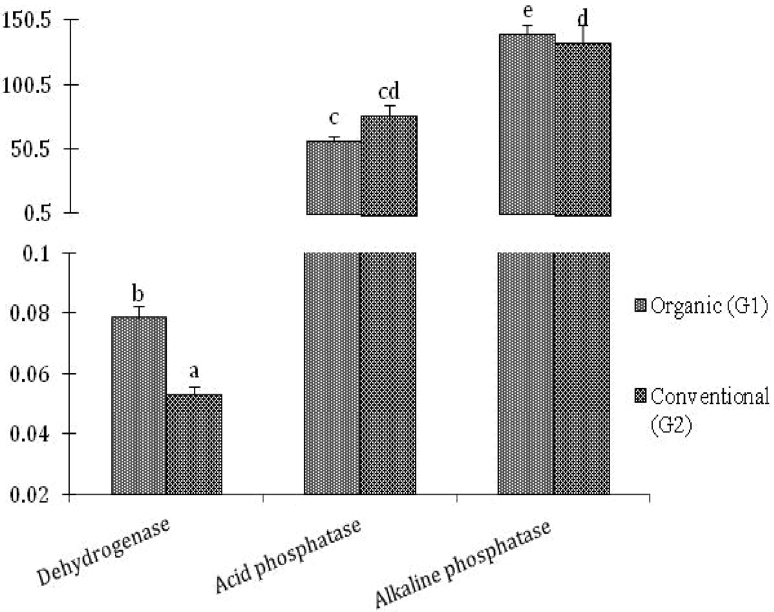
Figure 2. Comparative soil enzymes activities of conventional and organic treated mango rhizosphere soil the dehydrogenase , acid phosphatase and alkaline phosphatase activities were showing in µg TPF formed g −1 of soil h −1 and µg PNP g −1 soil h −1 respectively. The results are the average of five replicates (n = 5), with bars representing standard error. Significant differences based on the analysis variance (ANOVA) are shown by different letters above the error bars, followed by the post hoc DMRT test ( p ≤ 0.05) using the software